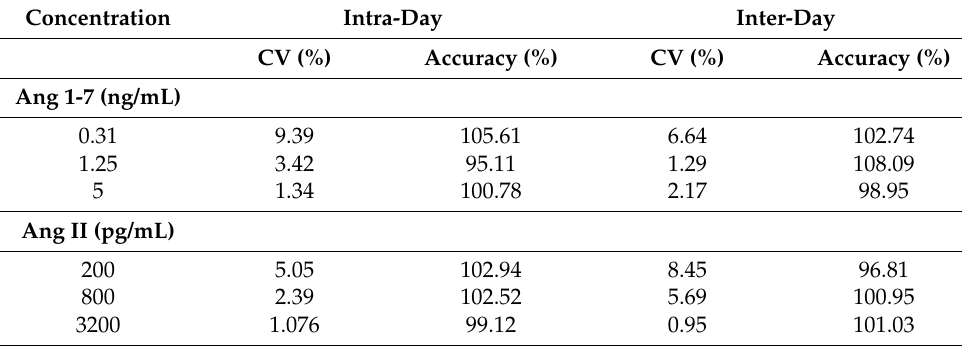
Table 2. Inter- and intra-day precision and accuracy of angiotensin peptides. Concentration Intra-Day